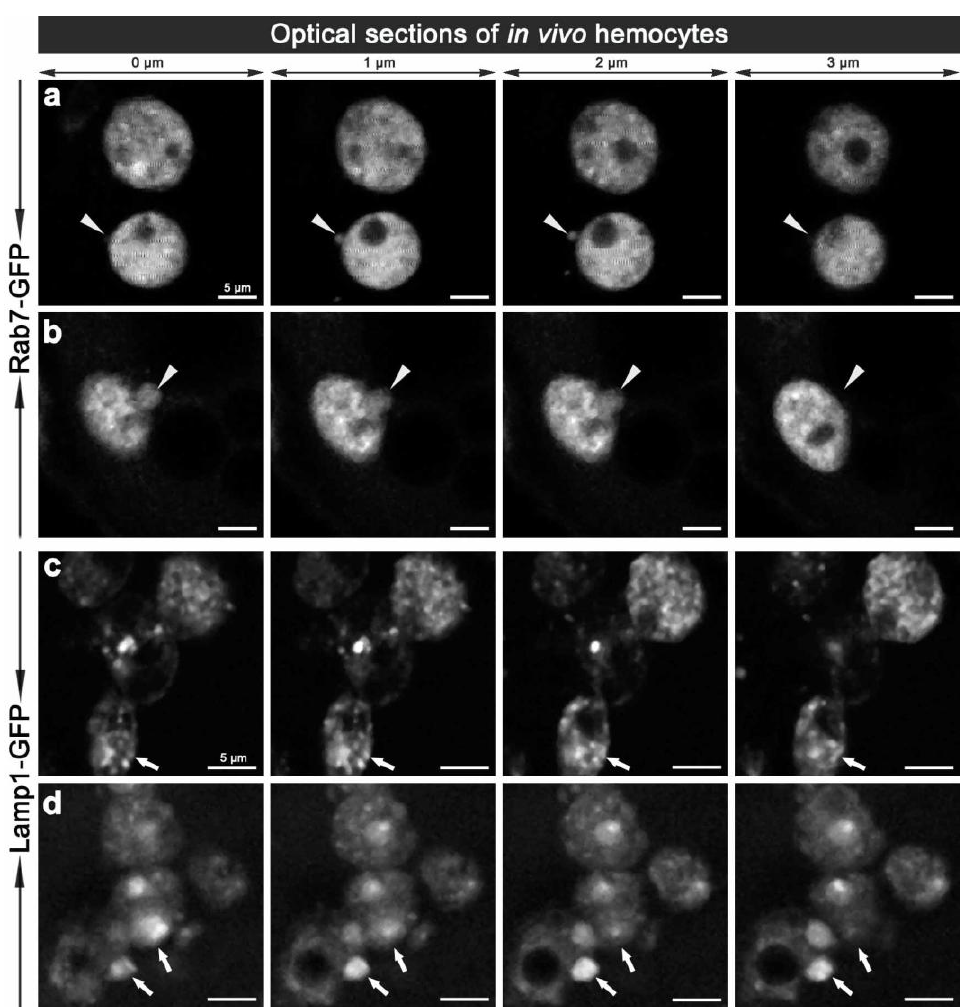
Figure 5. Two-photon micrographs illustrating the in vivo morphology of adult hemocytes carrying CG-GAL4>Rab7-GFP (a, b) and CG-GAL4> Lamp1-GFP (c, d) markers. Each row shows consecutive optical 1 (cid:80) m thin sections along the Z-axis with 0.5 (cid:80) m steps in- between, which are representative of Movie 4 and 4a (a) , and Movie 5 (b) . Arrowheads (a, b) depict the vesicles protruding from the hemocyte surface. Arrows (c, d) depict small or enlarged Lamp1-GFP compartments. Scale bars = 5 (cid:80)